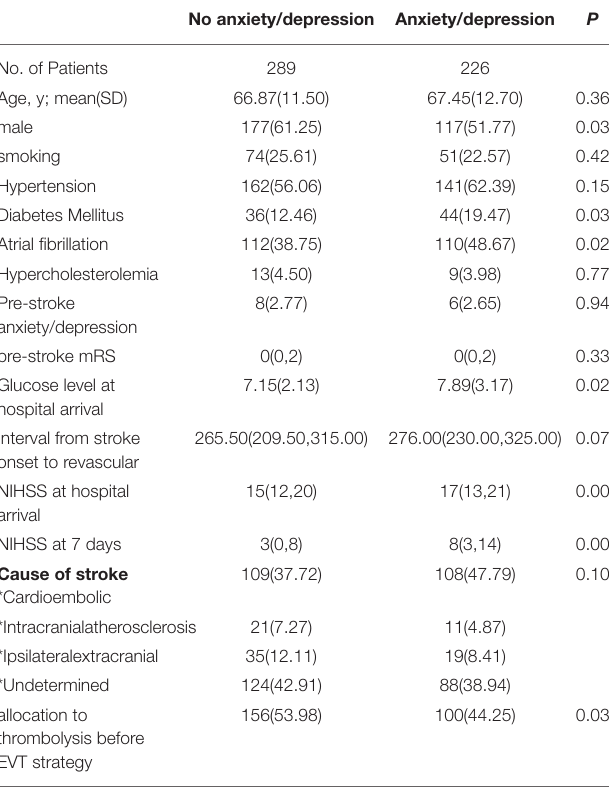
TABLE 1 | Comparison of the baseline characteristics of patients between anxiety/depression group and no anxiety/depression group. No anxiety/depression Anxiety/depression